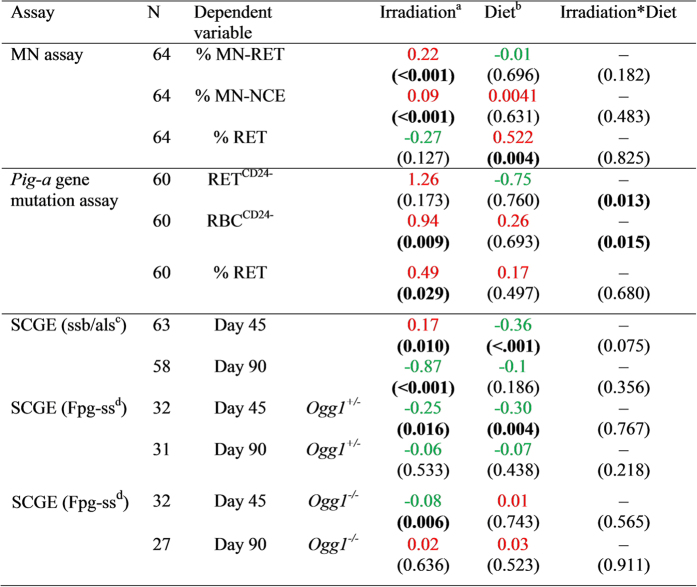
Differences of Least Square Means (LSM) of untransformed data between groups after AIC.cf. Statistical analysis in the method section. P-values for the factors irradiation and diet and their interaction (irradiation*diet) are given in brackets (in bold for p < 0.05). LSM are indicated in red for endpoints where irradiation or low Se diet had a stronger effect; LSM are indicated in green for endpoints where non-irradiation or normal Se diet had a stronger effect. aDifference of LSM between irradiated and non-irradiated mice (LSMIR – LSMnonIR). Positive values indicate a higher response in the investigated endpoint in the irradiated groups compared with the non-irradiated groups. bDifference of LSM between low and adequate Se diet (LSMlowSe – LSMnormSe). Positive values indicate a higher response in the investigated endpoint in the groups fed with low Se diet compared with groups fed with normal Se diet. cSingle strand breaks and alkali labile sites. dFpg-sensitive sites, i.e. oxidized DNA lesions.